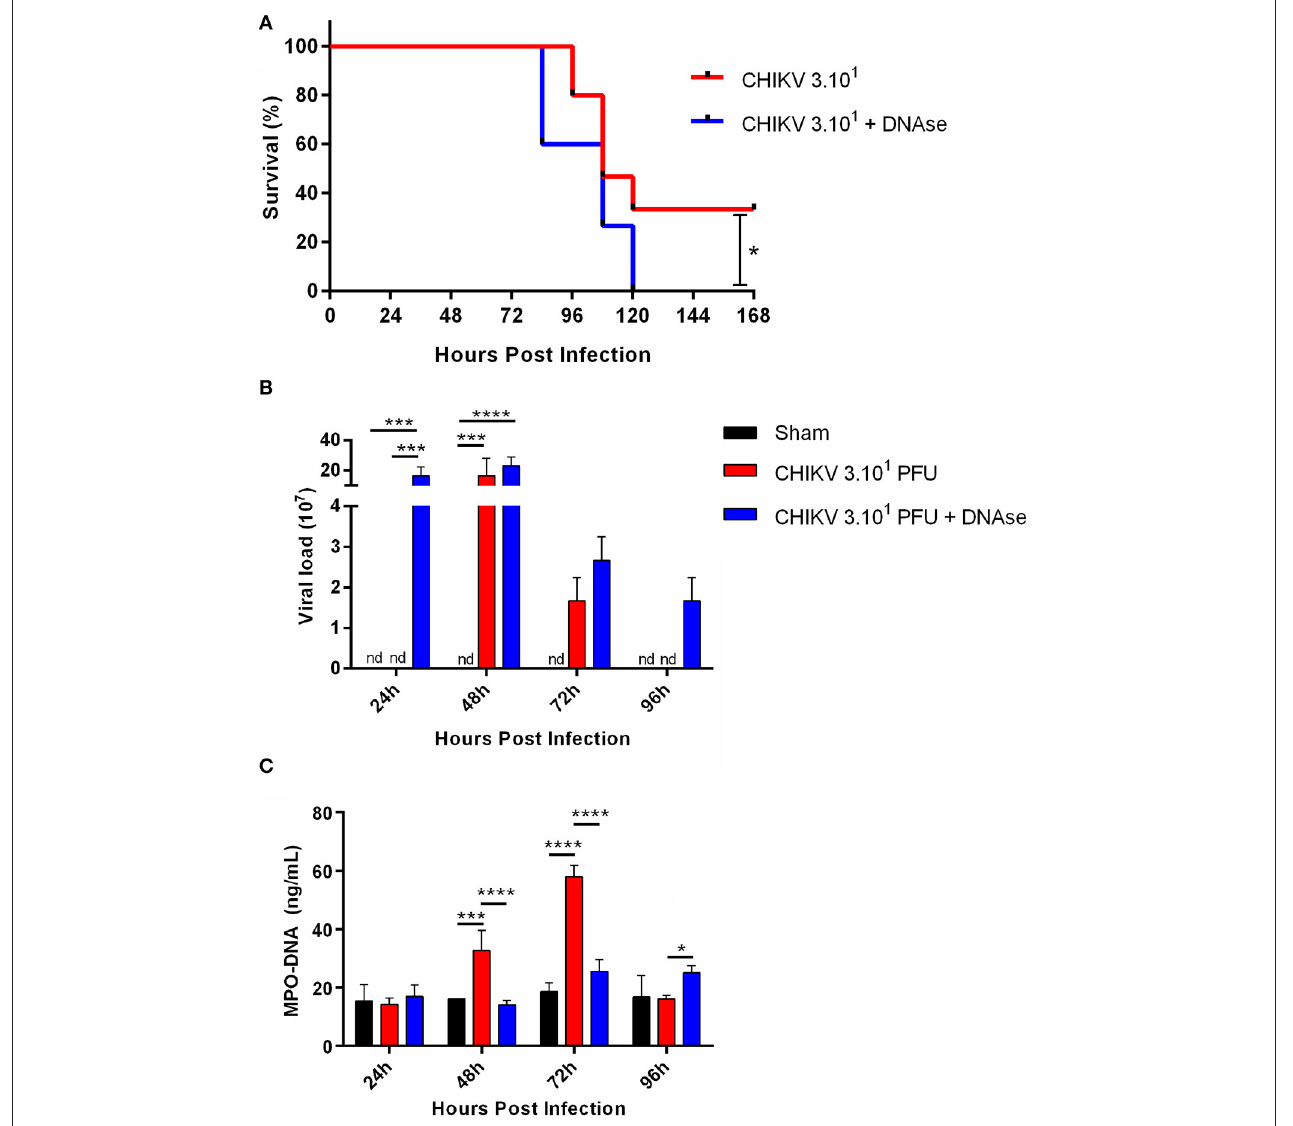
FIGURE 4 | DNase treatment increases viral load in vivo . (A) Survival of IFNAR − / − mice infected i.p. with 30 PFU of CHIKV and treated with saline or DNase (10 mg/kg, s.c., every 12h). (B) Quantification of NETs by MPO–DNA PicoGreen and (C) viral load in the plasma of infected IFNAR − / − treated with saline or DNase. Data are mean ± SD ( n = 10 per group); * p < 0.05, *** p < 0.001, and **** p < 0.0001, assessed by Mantel–Cox log–rank test (A) or two-way ANOVA with Bonferroni’s comparisons test (B,C) . Representative results of three experiments performed independently.